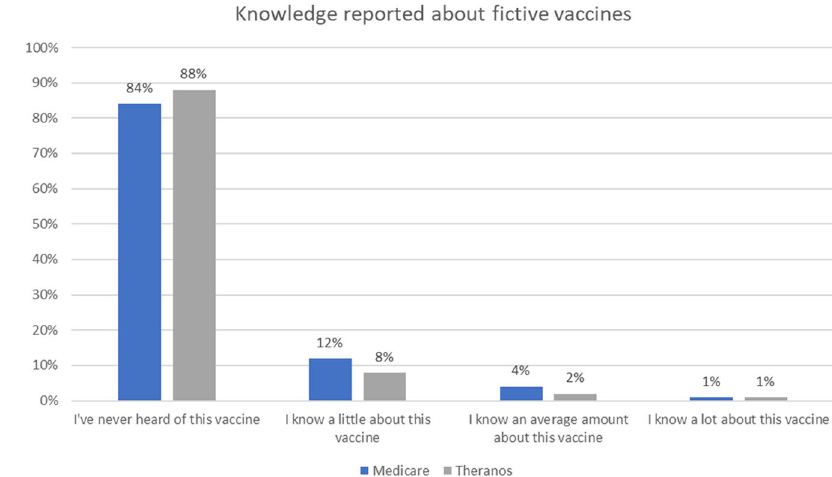
Fig. 1 Fictive vaccines. Percentage of respondents reporting different knowledge levels for the two fi ctive vaccines included in our study. HUMANITIES AND SOCIAL SCIENCES COMMUNICATIONS| (2022) 9:87